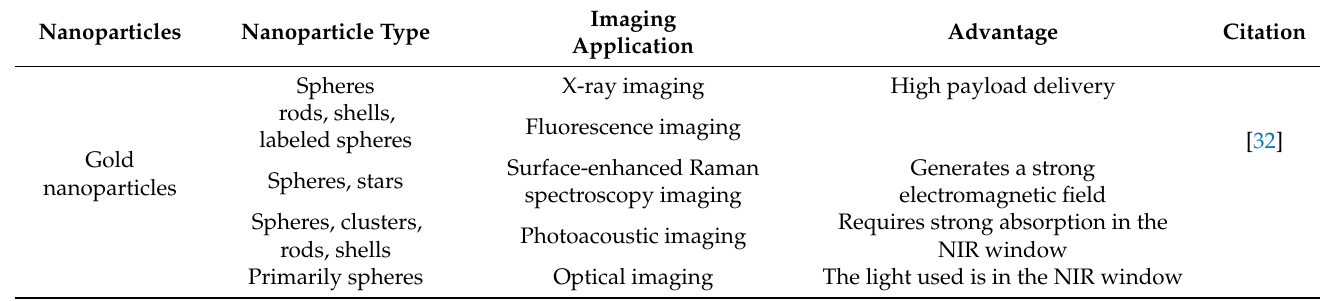
Table 3. Application of gold nanoparticles in cancer imaging and diagnosis.